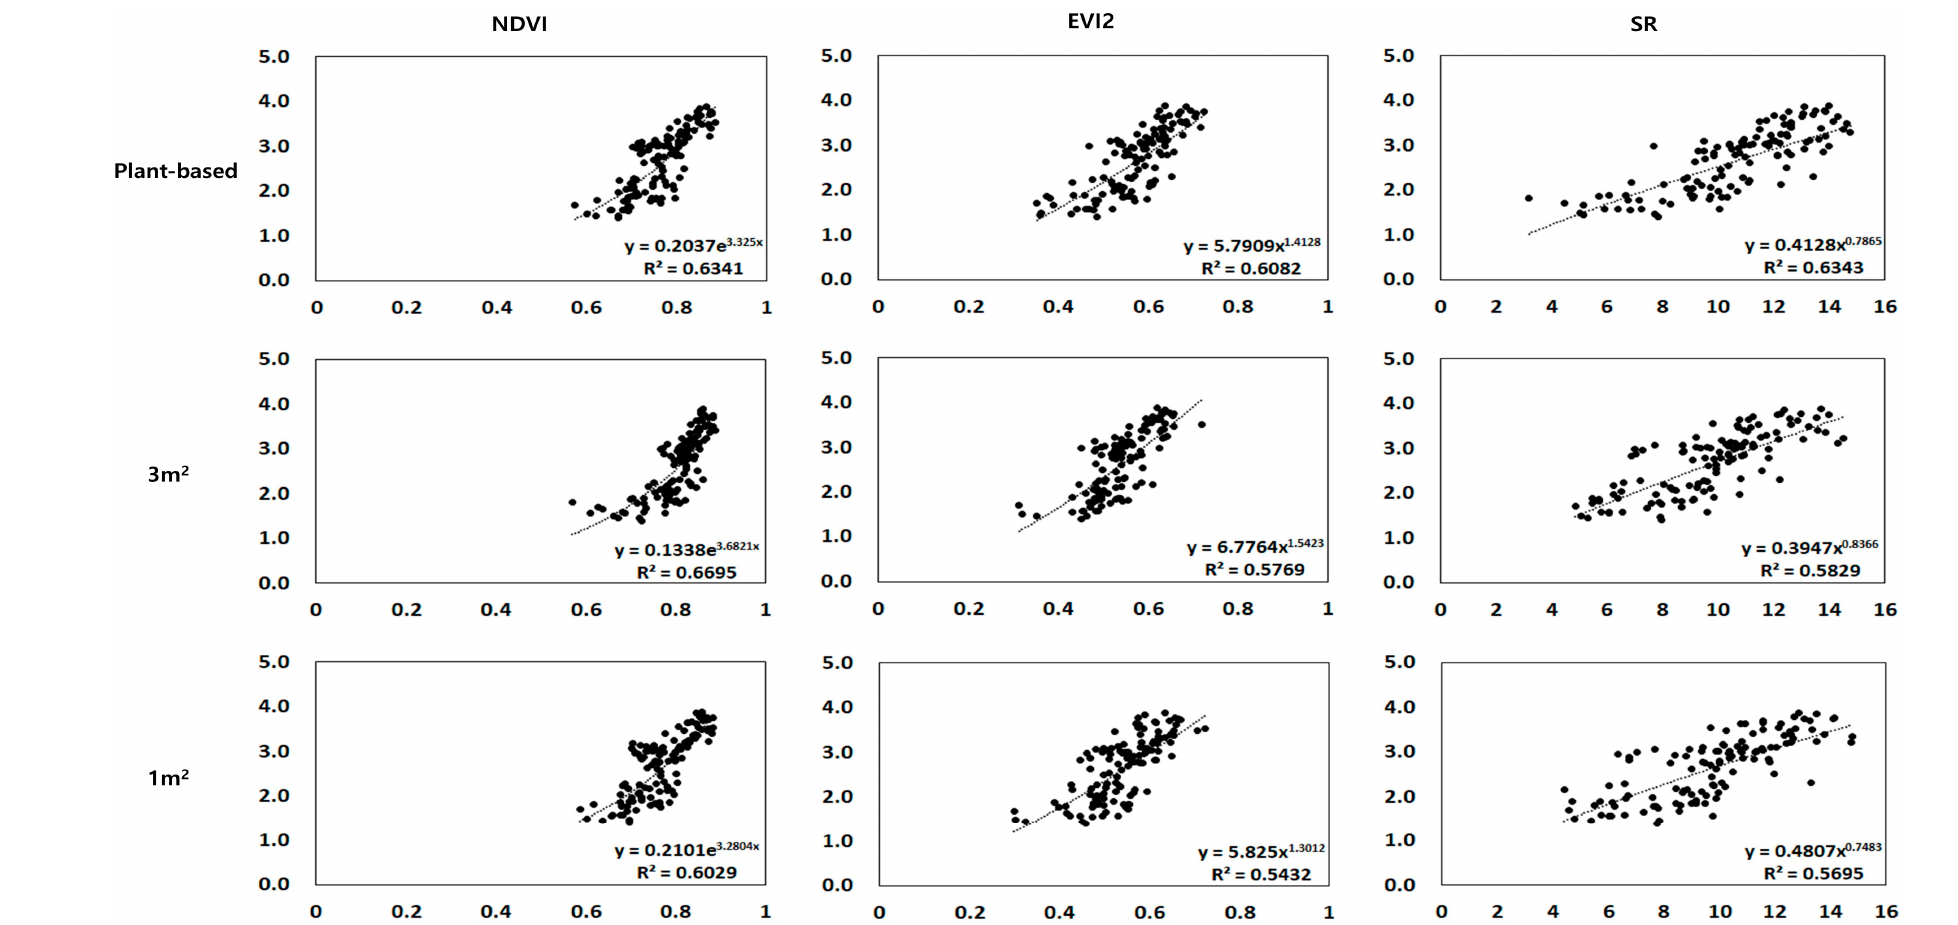
Figure 5. Scatter plots and fitted linear regression lines for the leaf area index (LAI) using the canopy analyzer LAI-2200 against the Normalized Vegetation Index (NDVI), Enhanced Vegetation Index 2 (EVI2), and Simple Ratio (SR) for all UAV data collection dates in 2018 (x—VIs, y—measured LAI). The VIs were obtained for each plant-based, 3 m 2 , and 1 m 2 buffer.